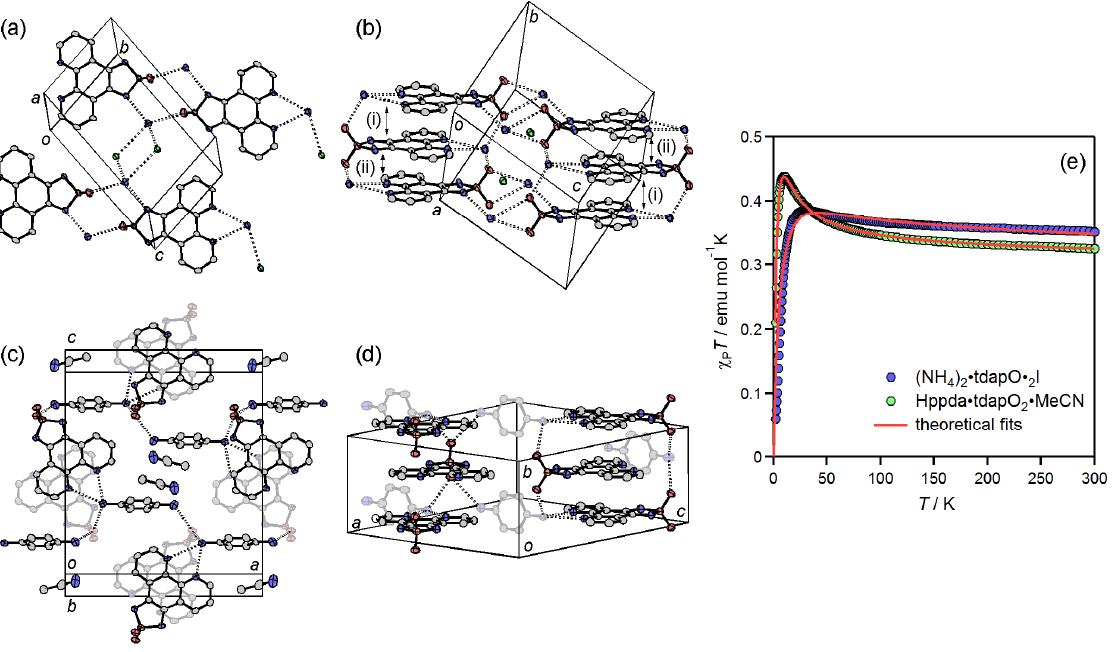
Figure 23. Hydrogen-bonding geometry around ammonium ions ( a , c ) and π -overlaps ( b , d ) ) •tdapO •I (top) and Hppda•tdapO of (NH 4 2 2